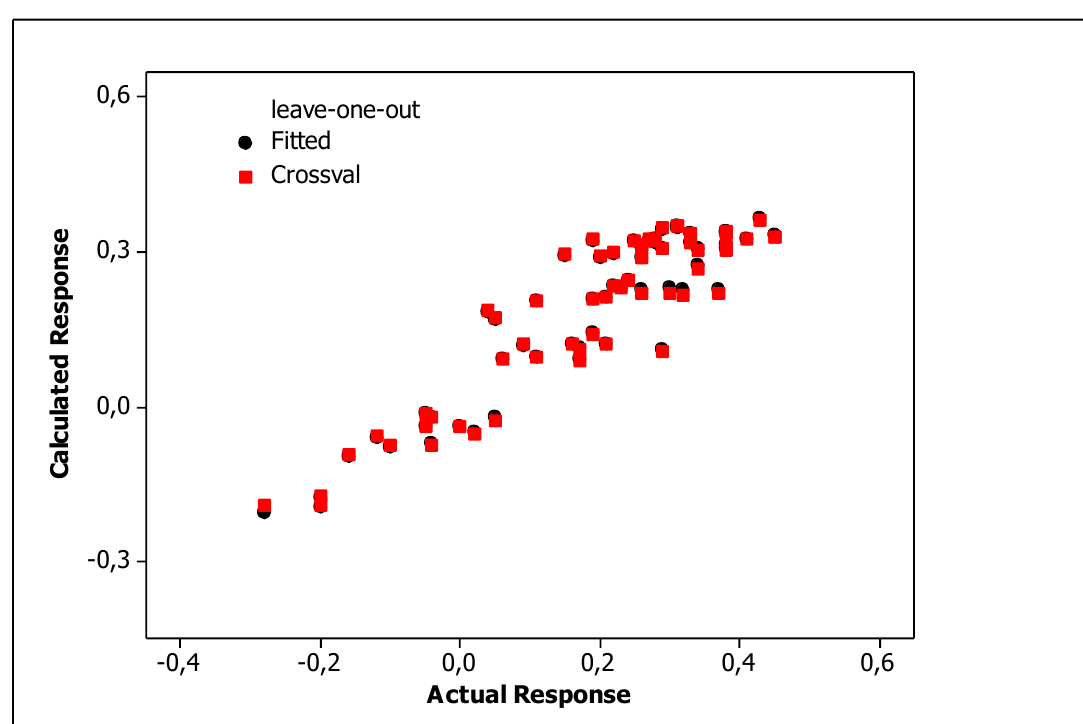
Figure 6. PLS response plots obtained for Equation (13).